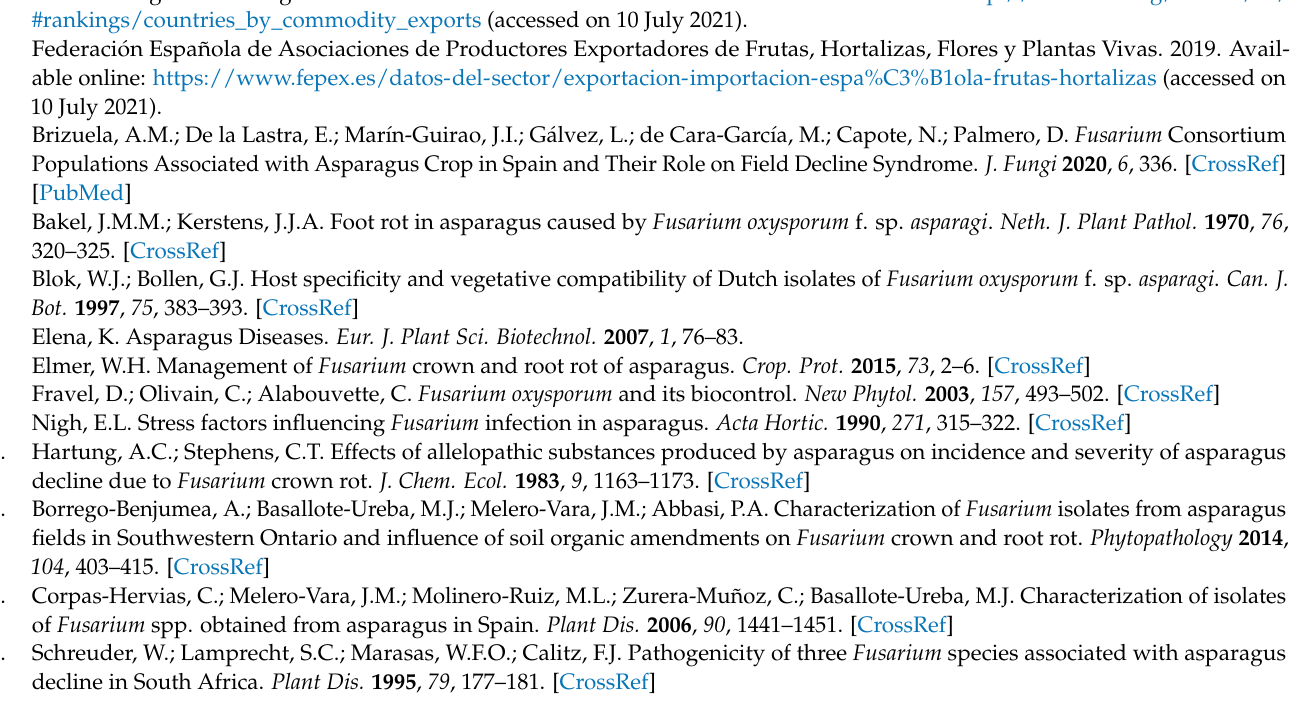
Figure S4: NEXUS partition file (annotation of exons/introns in TEF1A; RPB1, RPB2; coding only), Figure S5: Topology of the consensus tree obtained with IQ-TREE (Newick